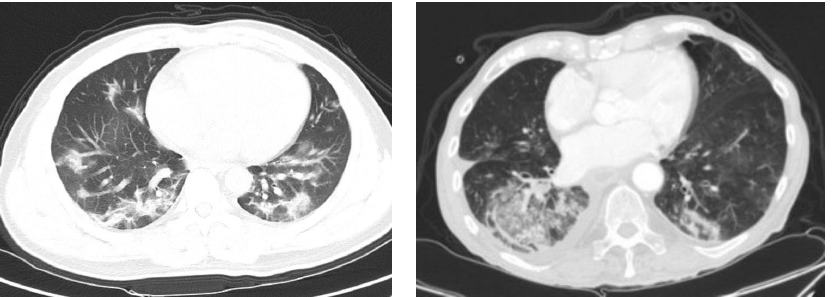
Figure 3. Sample CT images from the COVID-CT dataset. On the left, an image that represents a coronavirus pneumonia due to SARS-CoV-2 infection. On the right, image belonging to the non-COVID-19 class. Images are courtesy of